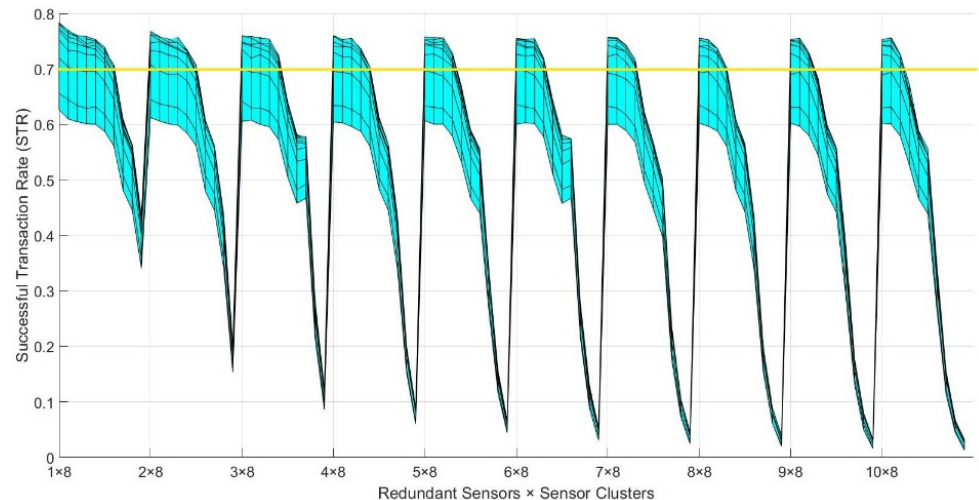
Figure 8. Example of frontal view of the trustworthiness mesh, corresponding to Figure 7c. The yellow line is used to construct the trustworthiness working domain shown in Figure 9.